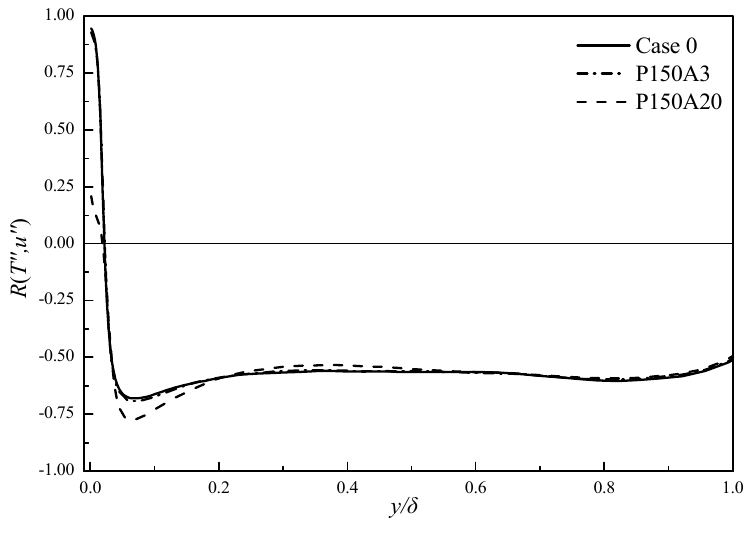
Figure 19. Cross correlations of (cid:1846) (cid:4593)(cid:4593) and (cid:1873) (cid:4593)(cid:4593) at x =40.775.